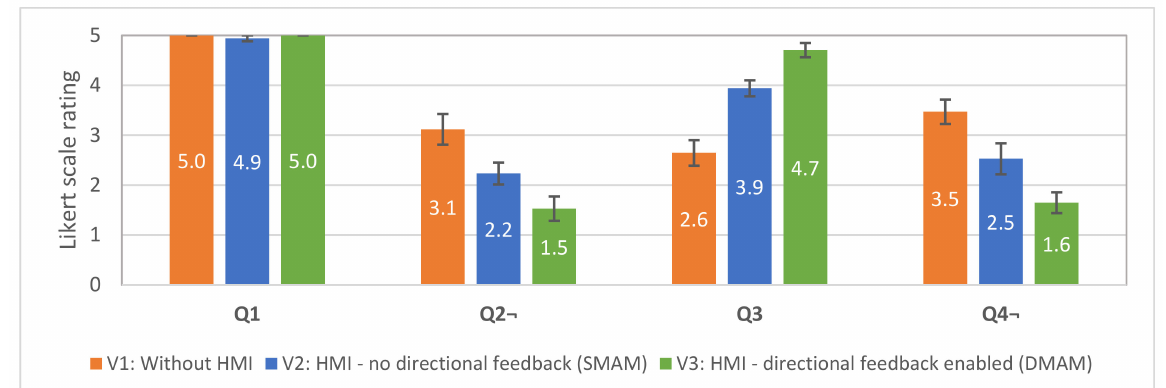
Figure 18. Average scores with standard errors for the questions Q1–Q4 used in the user study. Score 5 denotes “totally agree” and 1—“totally disagree”. Questions Q1, Q3—higher is better; Q2, Q4—lower is